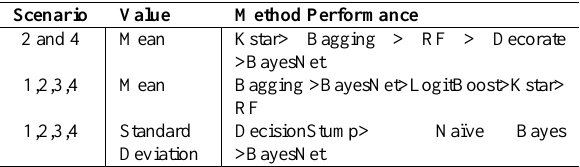
Table 4. Software fault prediction performance of